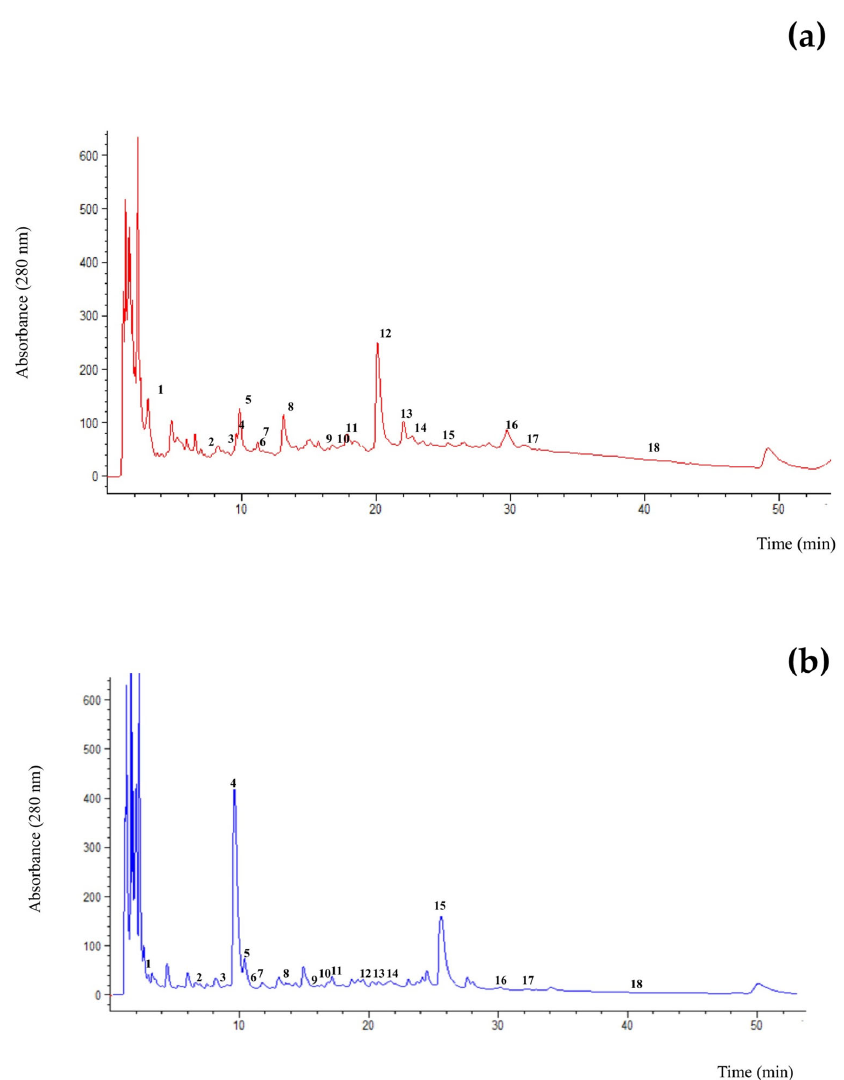
Figure 3. Phenolic profiles acquired at 280 nm, of ( a ) chicory and ( b ) fennel extracts obtained by applying UAE under the conditions that allowed the maximization of the relative TPCs. 1: Gallic